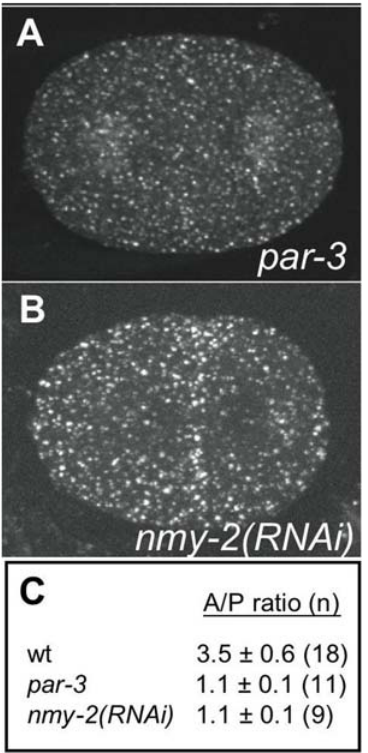
Figure 4. NMY-2 and PAR-3 are required for EE asymmetry. Projections of EEA-1 distributions in (A) par-3(it71) mutant, and (B) nmy-2(RNAi) embryo. Compare to similar staged wild-type images in Figure 1 (1G and 1I, respectively). Asymmetry is lost in par-3 mutant and nmy-2(RNAi) embryos. (C) Ratio of the number of EEA-1 positive puncta in an anterior region compared to a posterior region of the same